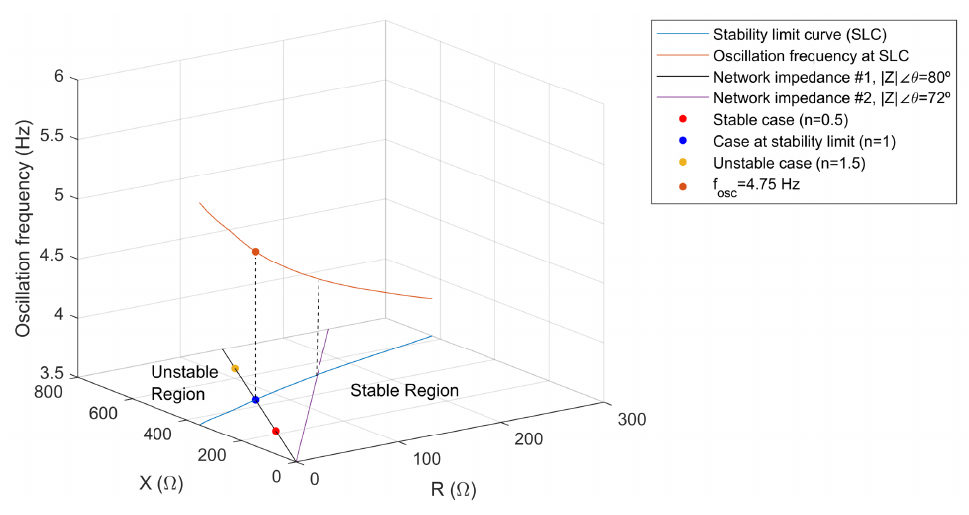
Figure 7. Stability limit curve of the traction chain in the network reactance ( X ) and resistance ( R ) complex plane with the corresponding oscillation frequencies. At P DC = 100 kW. Power supply system: 25 kV/50